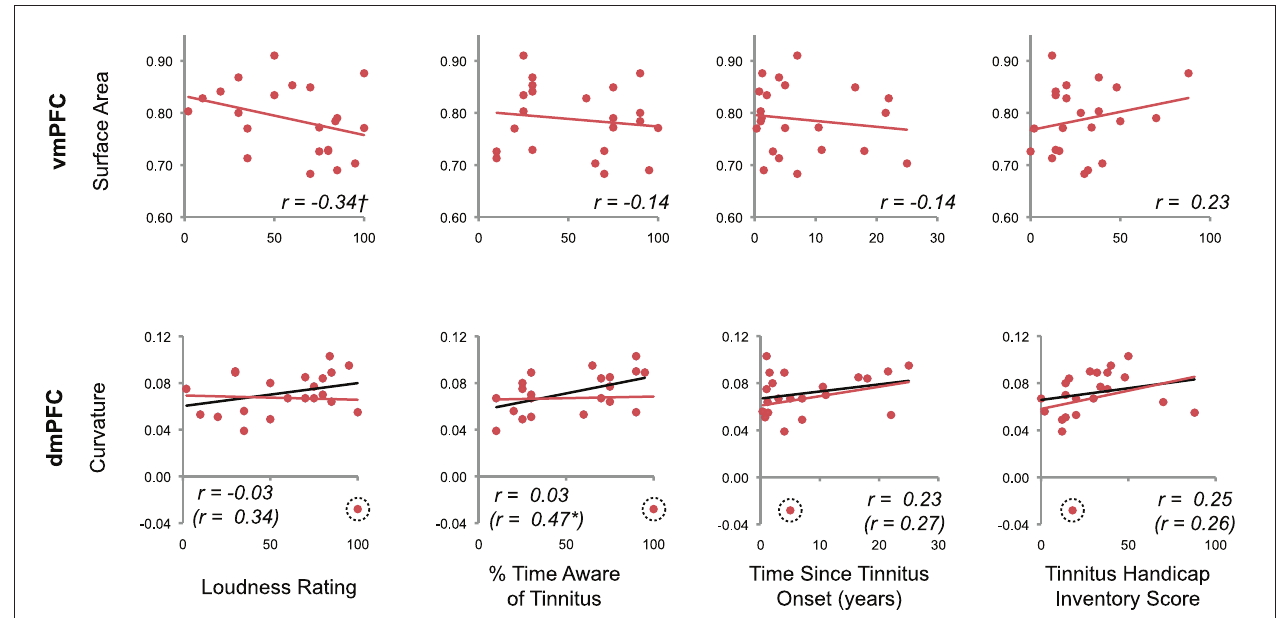
FIGURE 5 | Relationship between tinnitus severity and anatomical markers of tinnitus. For those clusters exhibiting a robust anatomical difference between tinnitus patients and controls, the relationship between morphological features and tinnitus characteristics are shown. Values for each subject are plotted, with corresponding regression lines and Pearson’s r values. A modest negative correlation was indicated between vmPFC surface